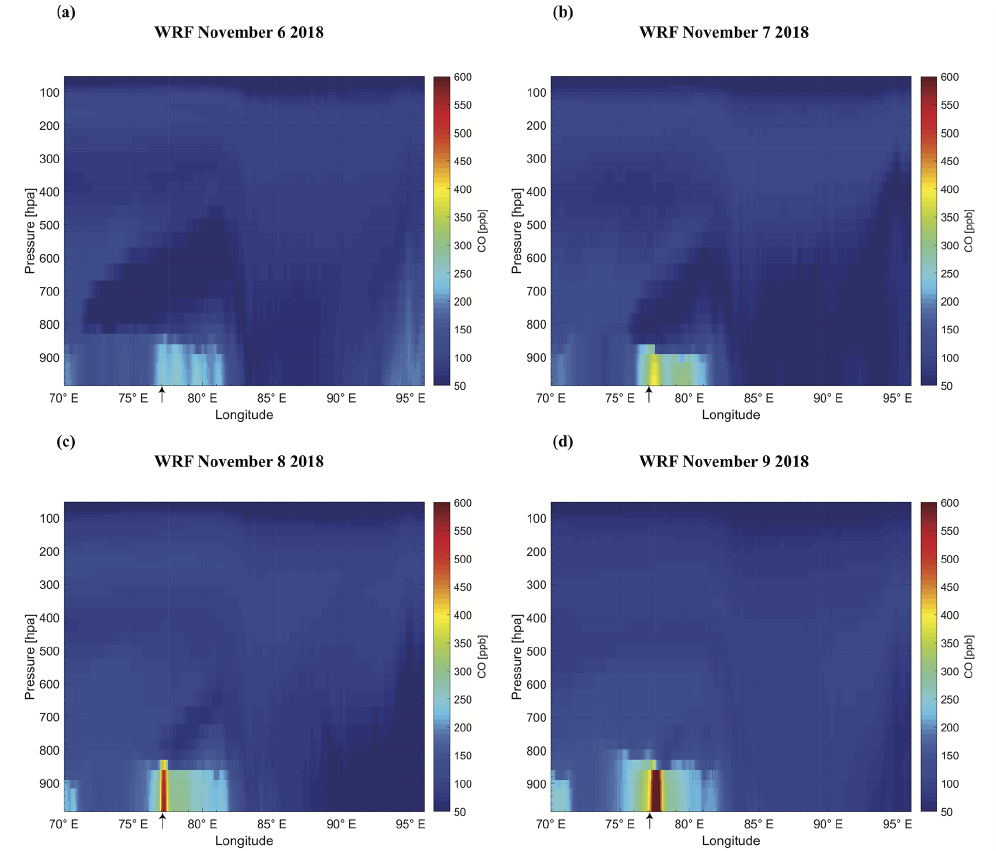
Figure 11. Same as Fig. 10 but showing total CO